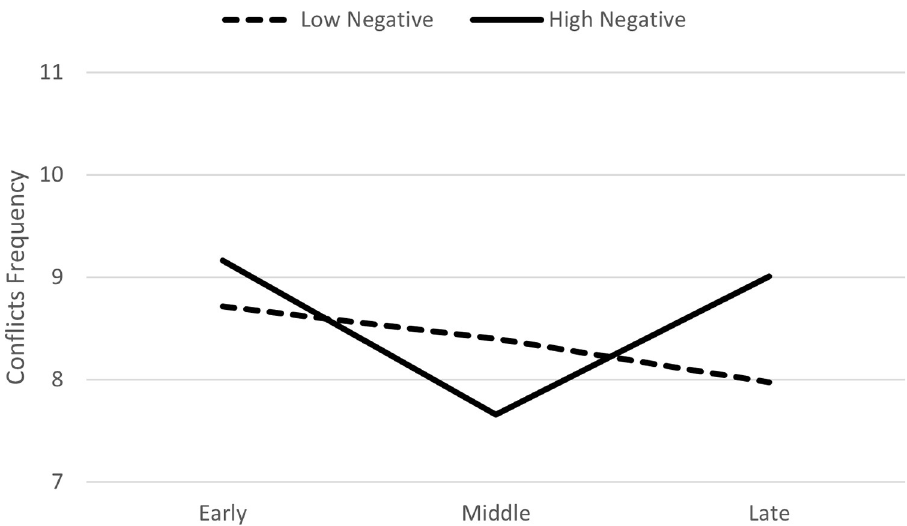
Fig 4. Change over time in frequency of conflicts as function of negative actions in the first phase of the relationship.